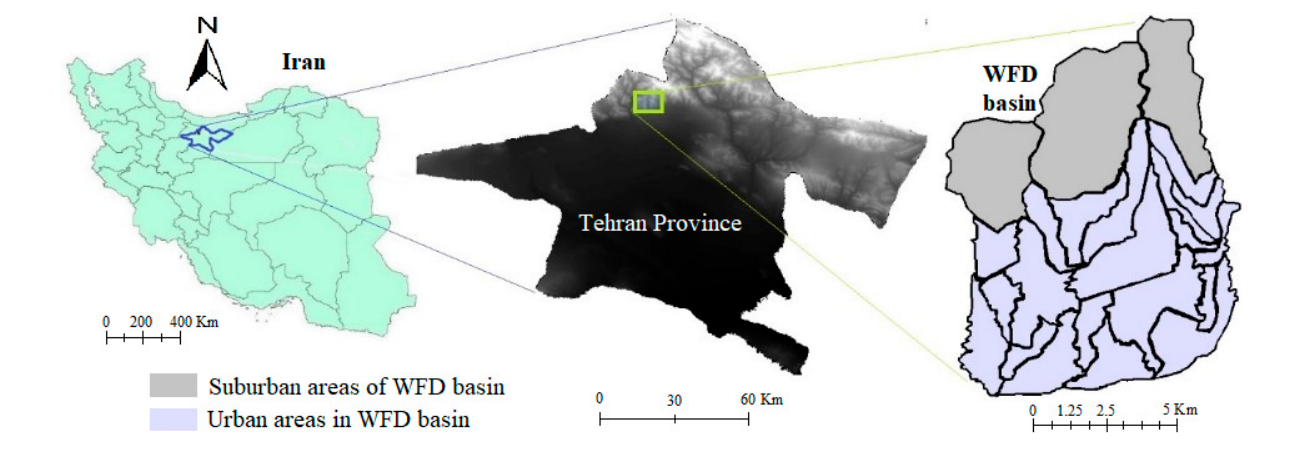
Figure 3. The situation of WFD catchment in Tehran (province) and Iran. Table 1. The sub-basins’ physiographic characteristics in WFD catchment [25].